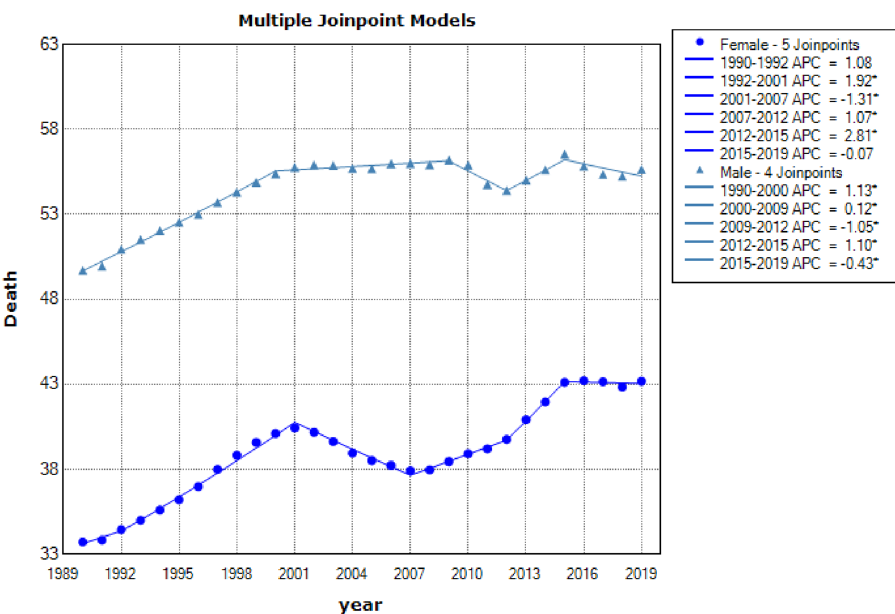
Figure 5. Joinpoint regression model for death due to ambient particulate matter exposure in aged +50 by gender: